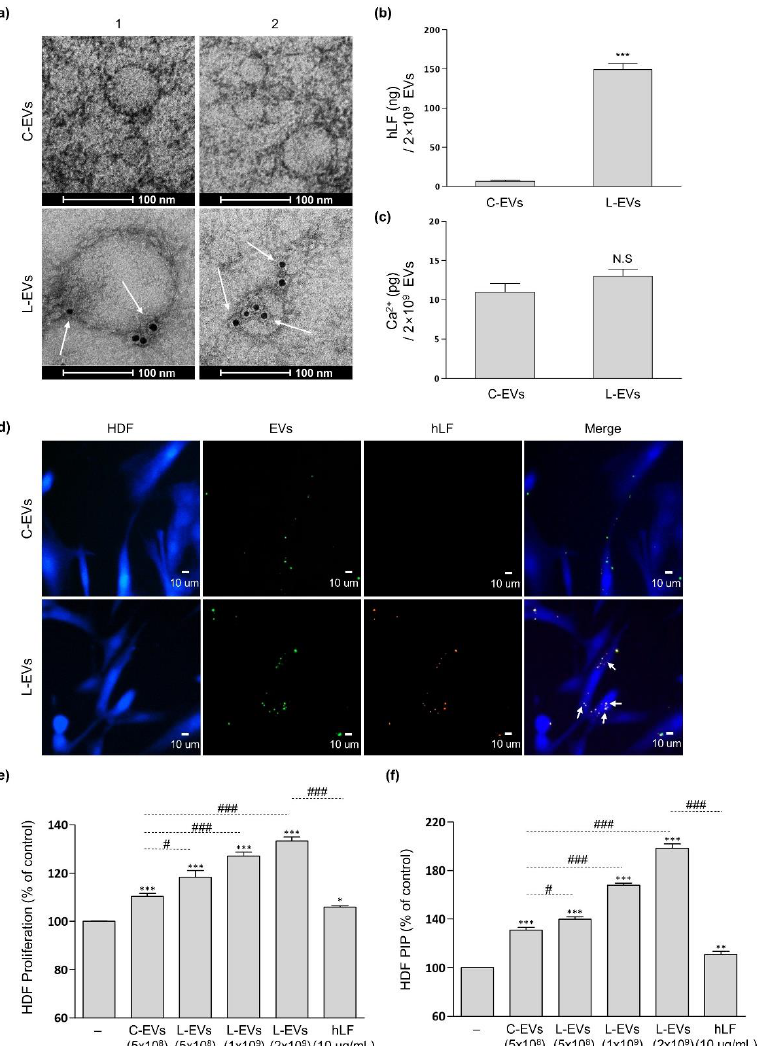
Figure 3. Binding of hLF to L-EVs and functional change of L-EVs. L-EVs and C-EVs were respectively separated from their hADSC-CMs. ( a ) TEM images showed hLF bound to the surface of L-EVs. The white arrows indicate anti-lactoferrin gold nanoparticles bound to L-EVs. Scale bars = 100 nm. ( b , c ) The amount of hLF and Ca 2+ contained in the L-EVs was compared to those contained in C-EVs (hLF: unpaired t -test, n = 4, p < 0.0001; Ca 2+ : unpaired t -test, n = 4, p = 0.1035). The data were obtained through two independent experimental groups. Error bars represent ± SD. *** p < 0.001, N.S (not significant) p > 0.05 were calculated versus the C-EVs. ( d ) Image of hLF moving to HDFs via L-EVs. 5 × 10 7 of DiO-stained EVs were used for both L-EVs and C-EVs. The white arrows indicate EVs stained simultaneously with anti-lactoferrin antibody (red) and DiO (green). HDF were stained by CellTracker (blue). Scale bars = 10 µ m. ( e , f ) HDF proliferation and pro-collagen synthesis by C-EVs or L-EVs evaluated in terms of their number. The data were investigated using the MTT assay or PIP-ELISA after EVs or hLF were applied for 2 days. The data were obtained through three independent experimental groups (proliferation: one-way ANOVA, n ≥ 6, p < 0.0001; pro-collagen: one-way ANOVA, n ≥ 6, p < 0.0001) and significance between pairs was analyzed using post hoc, Tukey’s test. Error bars represent ± SD. * p < 0.05, ** p < 0.01, *** p < 0.001 were calculated versus the negative control. In the case of pairs connected by the dotted line, the difference between them was noted as # p < 0.05, ### p